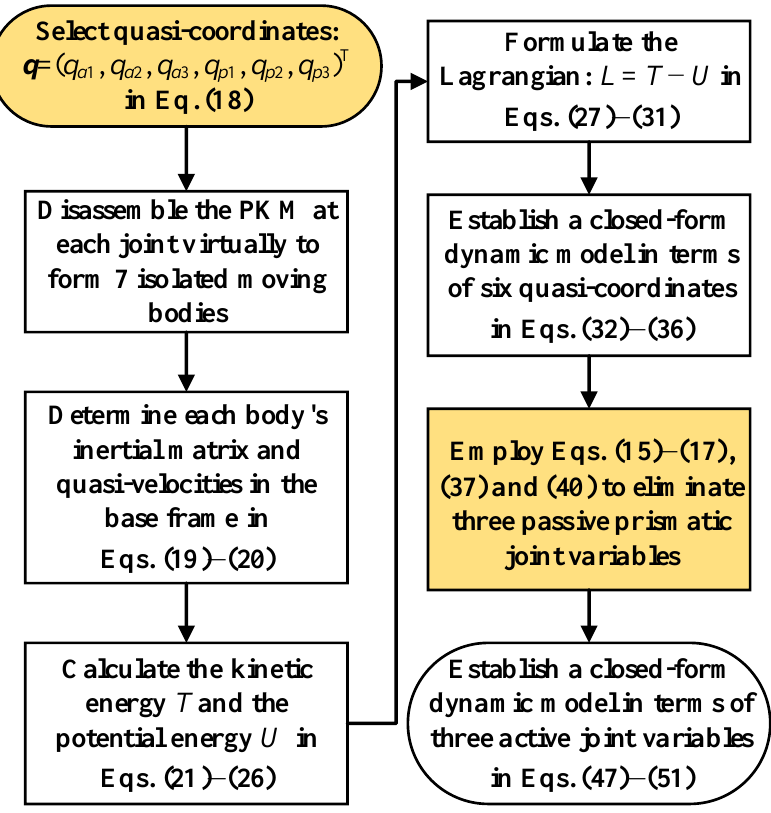
Figure 4. The derivation process of the proposed dynamic modeling approach. As shown in Figure 5, body frames fixed at center of mass (COM) of the three active prismatic joints are numbered from 1 to 3, body frames fixed at COM of the three passive prismatic joints are numbered from 4 to 6, body frame 7 is fixed at the COM of the moving platform with the same orientation as the frame M , and the fixed base frame B of the 2R1T 3PPS PKM is labeled as frame